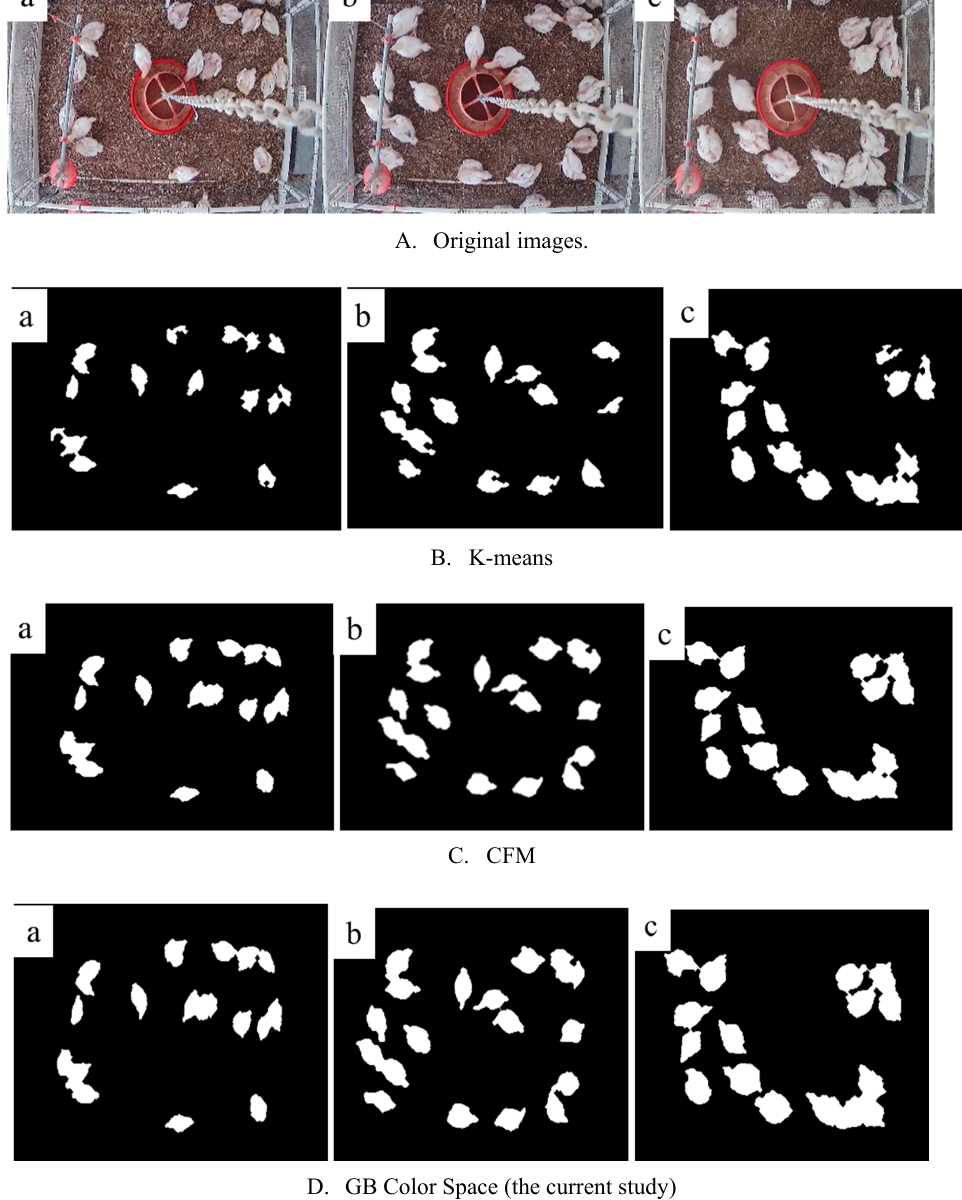
Figure 5. The visualization efficiency of three different methods ( a , b , and c represent images taken on d18, d24 and d30, respectively).